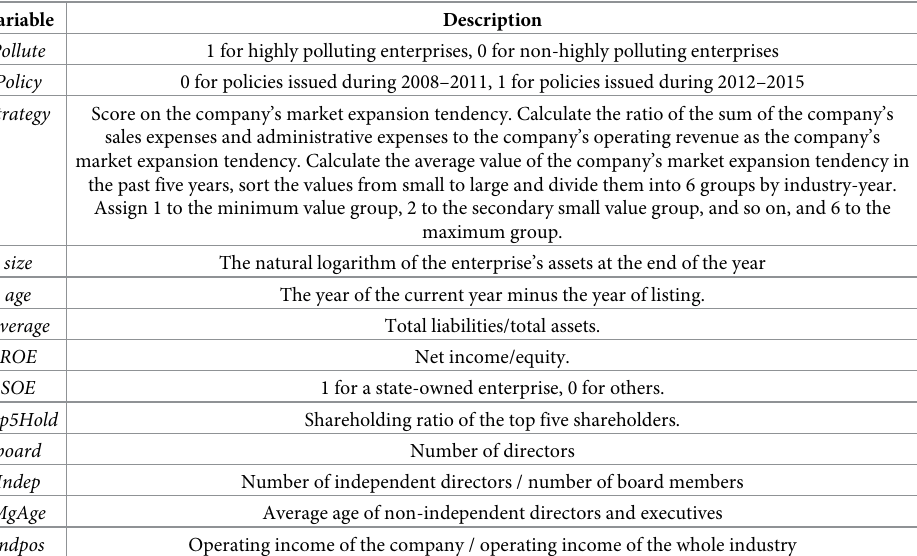
Table 1. Descriptions of